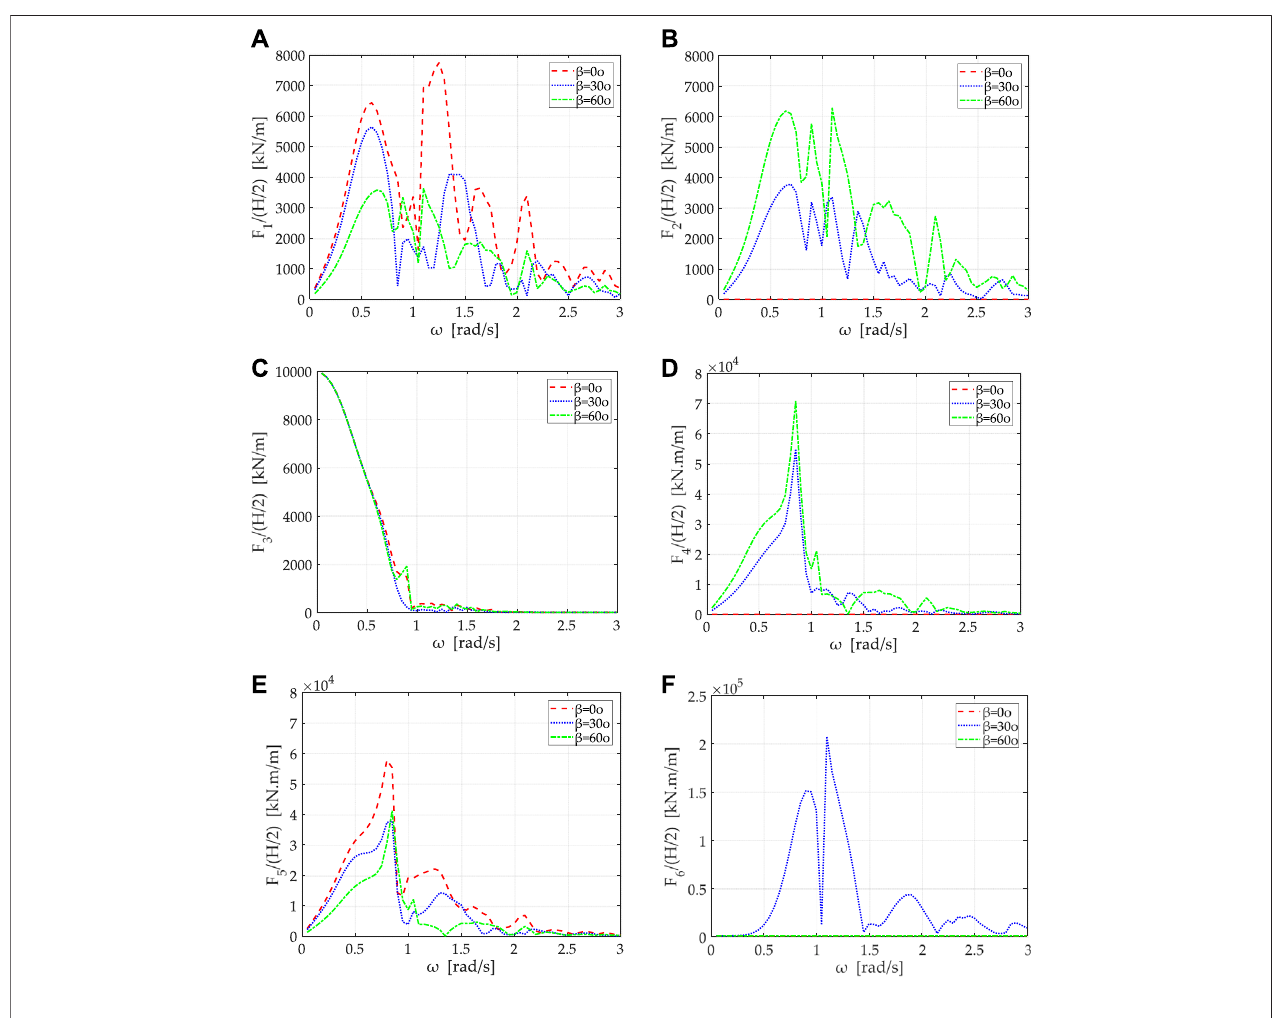
FIGURE 5 | Exciting forces and moments on the hybrid structure for wave angles 0, 30, and 60 degree versus wave frequency: (A) F 1 /(H/2), (B) F 2 /(H/2), (C) F 3 /(H/2), (D) F 4 /(H/2), (E) F 5 , (F) F 6